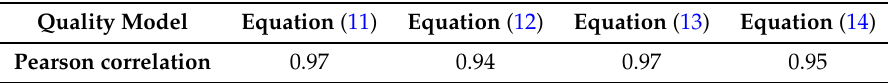
Table 4. Values of the Pearson correlation between the MOS V values and the quality models defined in Equations (11)–(14) with regard to the digital data presentation.